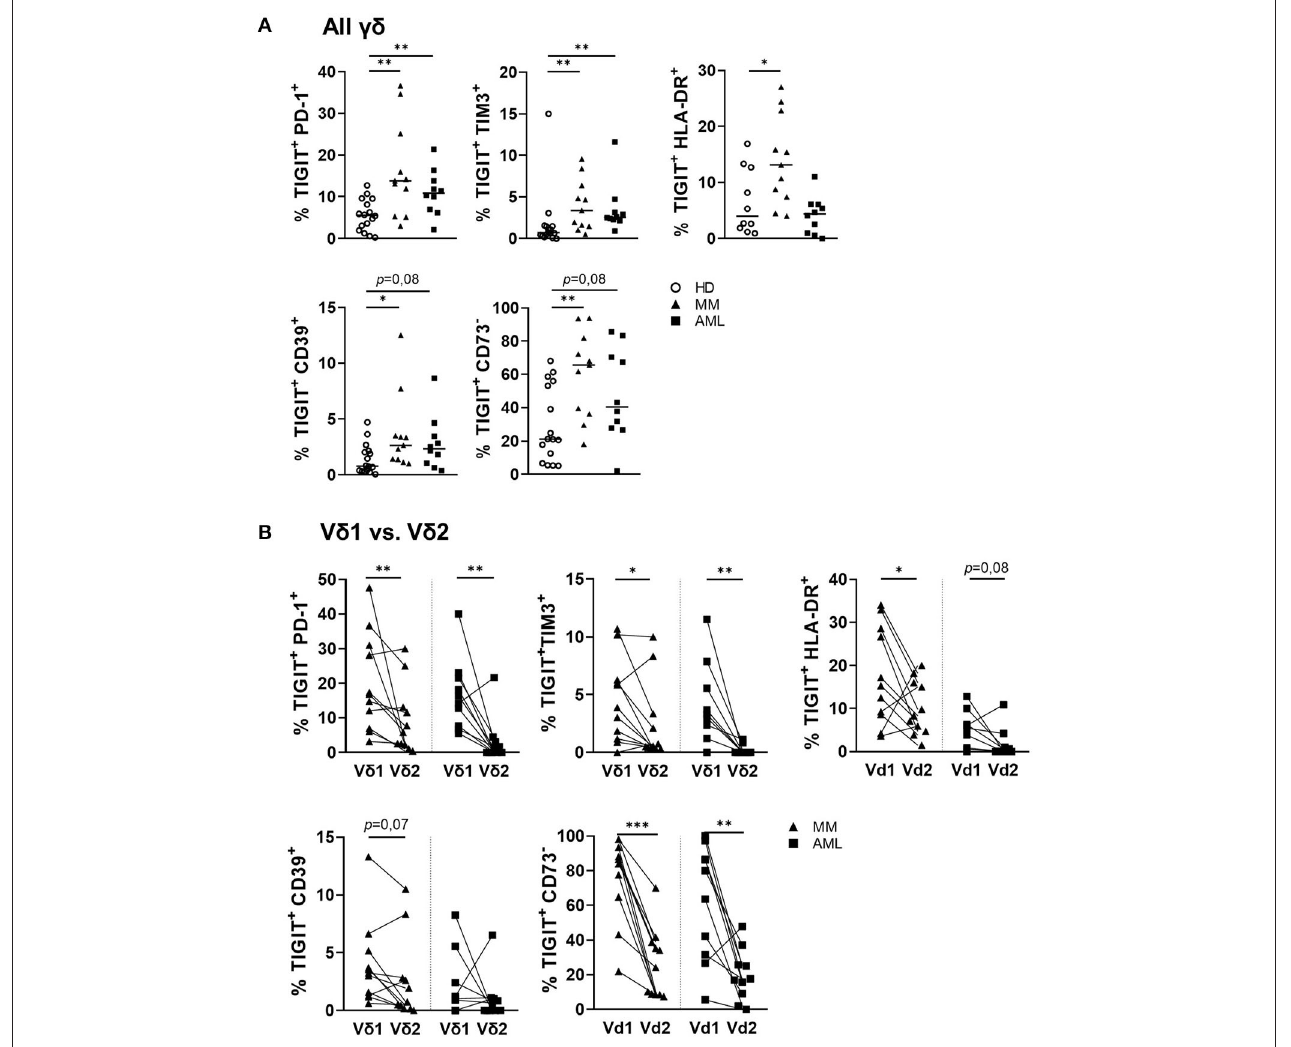
FIGURE 5 | PD-1 and TIM-3 are co-expressed with TIGIT on γδ T cells in AML and MM. The co-expression of PD-1, TIGIT, TIM-3, CD39, CD73, and HLA-DR was compared between γδ T cells from peripheral blood (PB) of healthy donors (HD, white circles, n = 16), and bone marrow (BM) aspirates from patients with multiple myeloma (MM, black triangles, n = 11), and newly diagnosed AML (AML, black rectangles, n = 10). (A) Summary data are illustrating the co-expression of PD-1, TIM-3, CD39, CD73, and the HLA-DR receptor with TIGIT on γδ T cells. P -values were obtained by the Mann-Whitney test. * P < 0.05, ** P < 0.01, *** P < 0.001.